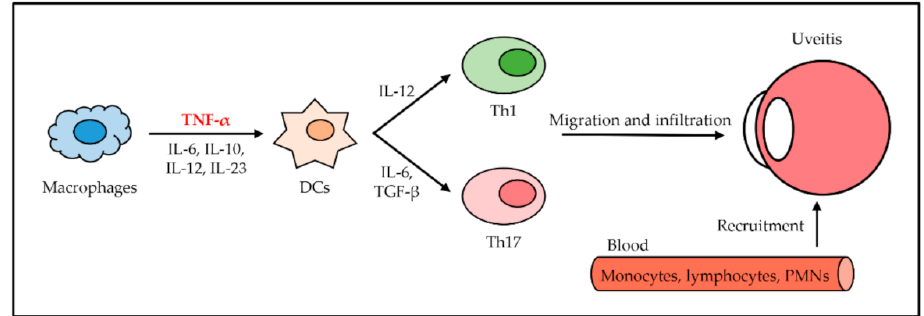
Figure 5. The role of TNF- α in uveitis. TNF- α is secreted from macrophages with other cytokines and activates DCs. Activated DCs secrete IL-12, IL-6, and TGF- β to induce differentiation of Th1 cells and Th17 cells from naïve T cells, respectively. Th1 cells and Th17 cells arrive at the uvea through migration and infiltration. Several leukocytes from blood are recruited by Th1 cells and Th17 cells. NIU occurs due to